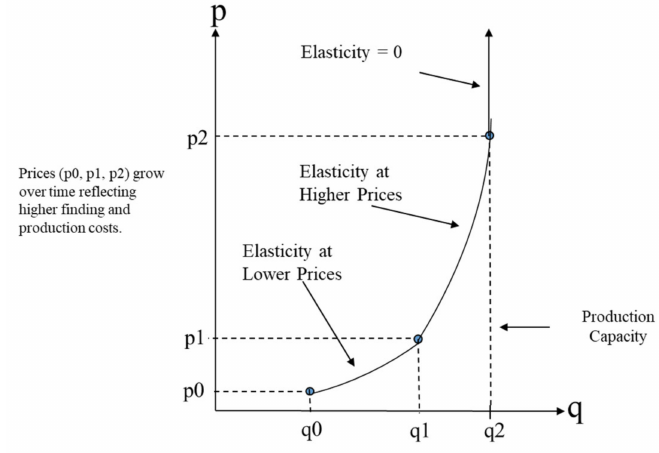
Figure 5. A supply function at a period.